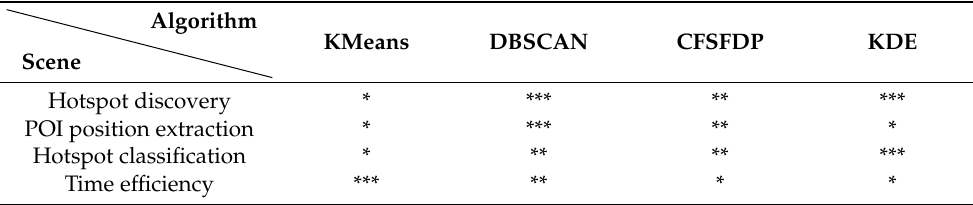
Table 10. Applicability of each algorithm in different